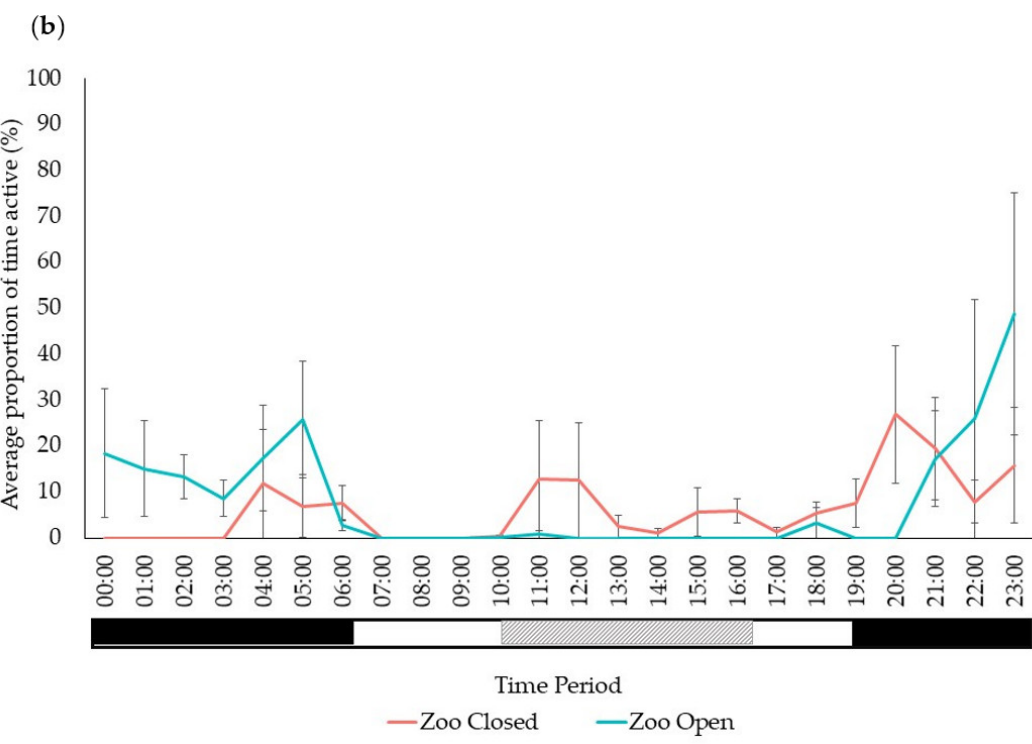
Figure 2. ( a ) Mean (±1 SE) proportion of time spent active when visible across a 24 h period for two Palawan binturong ( Arctictis binturong whitei ) throughout the whole data collection period and ( b ) Mean (±1 SE) proportion of time spent active across a 24 h period for two binturong split into periods of time in which Chester Zoo was open and closed to members of the public due to the COVID-19 pandemic. The box along the x axis represents the photoperiod: periods of darkness (black) and periods of daylight (white) using dawn and dusk times [www.weatheronline.com (accessed on 14 March 2020)]. The grey hashed lines represent zoo visiting hours for members of the public during the ‘Zoo open’ condition.